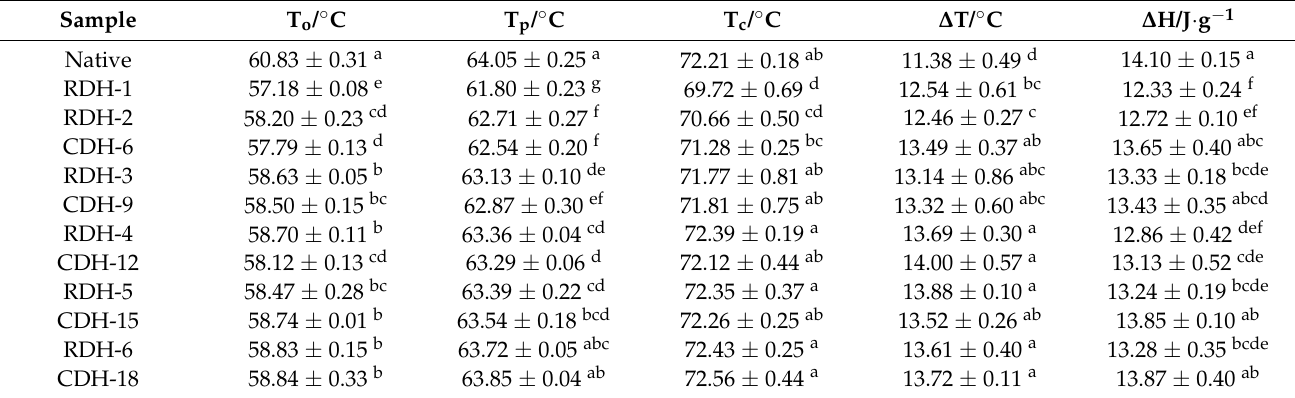
Table 3. Thermal properties of the native, CDH- and RDH-treated potato starch samples.